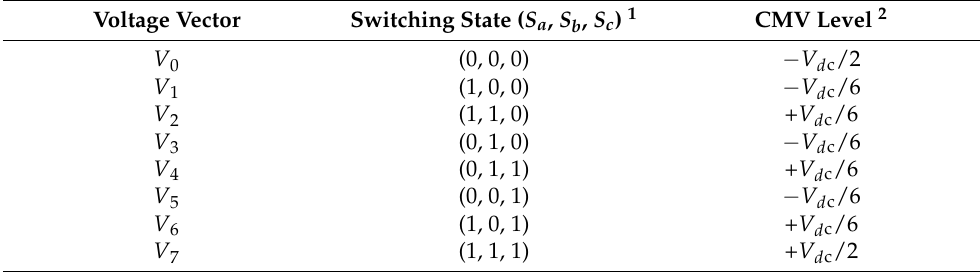
Table 1. CMVs in a traditional three-phase two-level